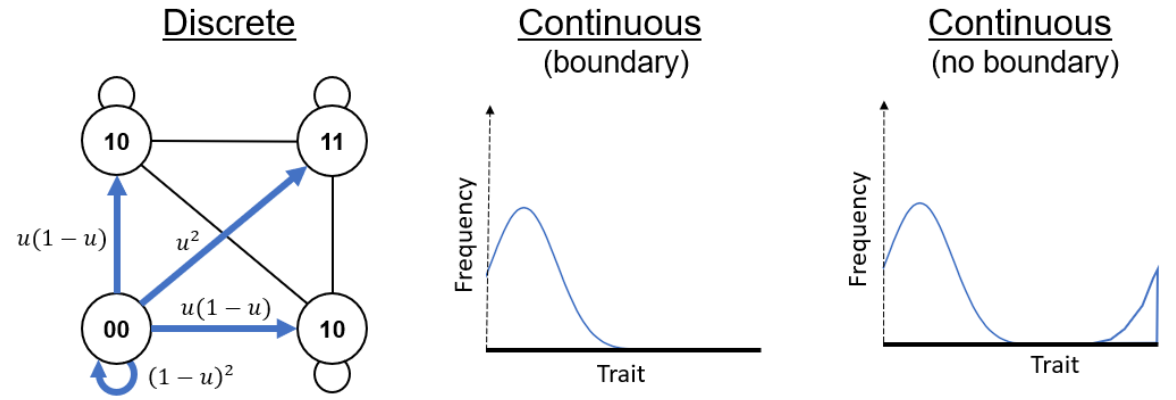
Figure 1. Diagrams of three models for mutation. First is finite strings on a finite alphabet with independent, uniform mutation on each letter. The arrows represent the possible mutations from 00 with their corresponding probabilities, with the remaining lines being possible mutations from other initial traits. The next two show local mutation on continuous traits. Mutations outside the boundary is truncated in the middle plot, and wraps around in the final plot. This removes the boundaries in the last model, making the trait space a circle. The local mutation is shown as a normal distribution, but it could be any curve, for example, an indicator function of width u